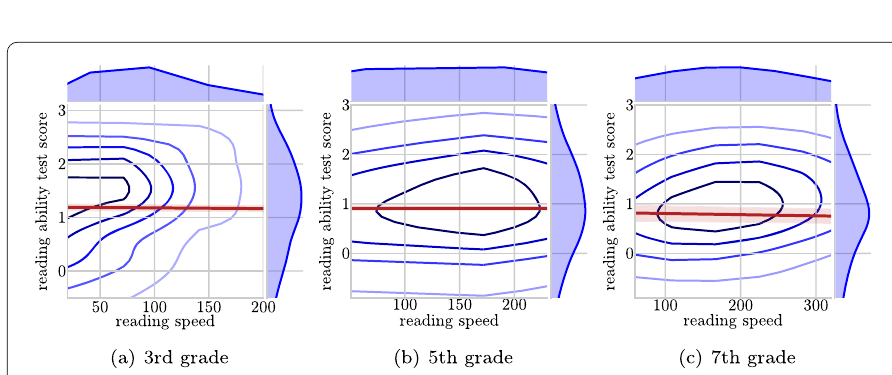
Figure 2 Kernel density plots, predicted line and confidence intervals for the relationship between average reading speed and reading ability test scores on all the data (prior to inclusion criteria). Grades three, five and seven. Reading speed from September through November 2019. Reading ability test scores from April